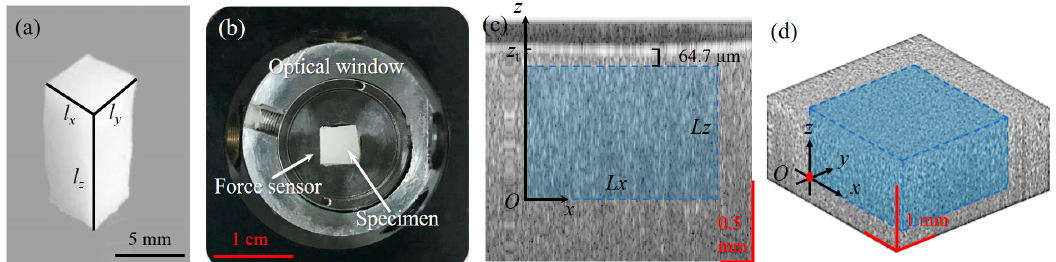
Figure 3. A sample of homogeneous phantom. ( a ) A photo of the phantom; ( b ) a photo of the phantom under compression; ( c ) a 2D OCT image of the phantom, where the ROI is marked with a blue rectangle; ( d ) a 3D OCT image of the phantom, where the ROI is marked with a blue cube.